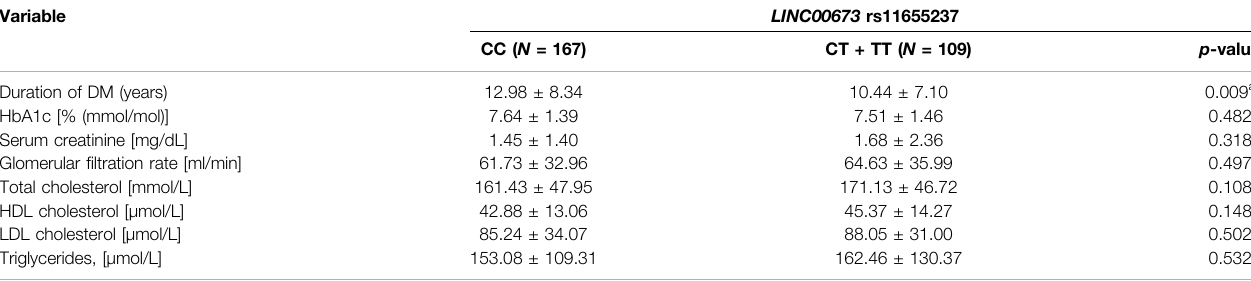
TABLE 5 | Clinical characteristics of diabetic retinopathy individuals according to LINC00673 rs11655237 genotypes. Variable LINC00673